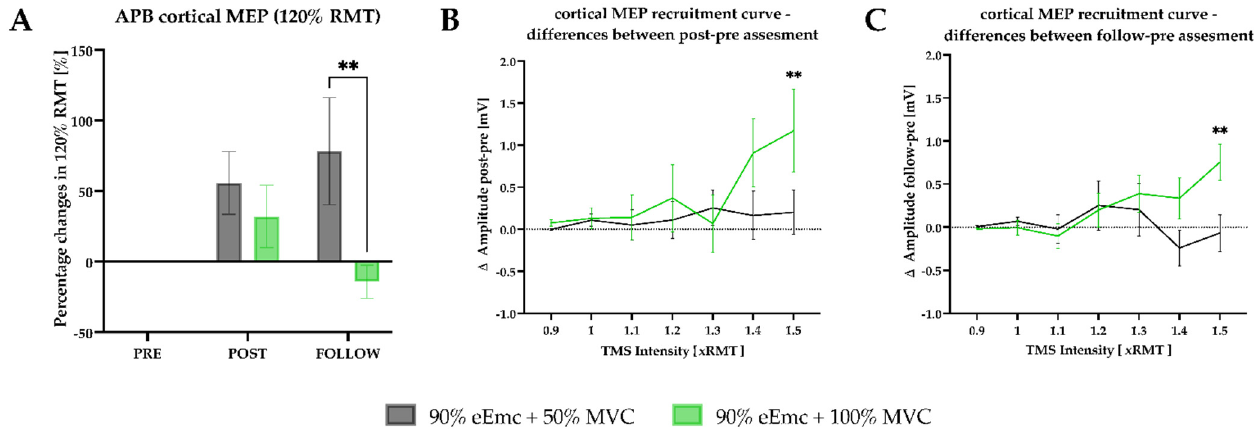
Figure 6. Cortical excitability outcomes. ( A ) percentage changes in cortical MEP from 120% of RMT according to baseline. Intervention simple effect showed significant differences at follow (*** p = 0.0017); ( B ) difference amplitude between post and pre cortical MEP recruitment. Intensity simple effects showed significant differences at 1.5 RMT multiple (** p = 0.0059); ( C ) difference amplitude between follow and pre MEP recruitment. Intensity simple effects showed significant differences at 1.5 RMT multiple (** p = 0.0063).